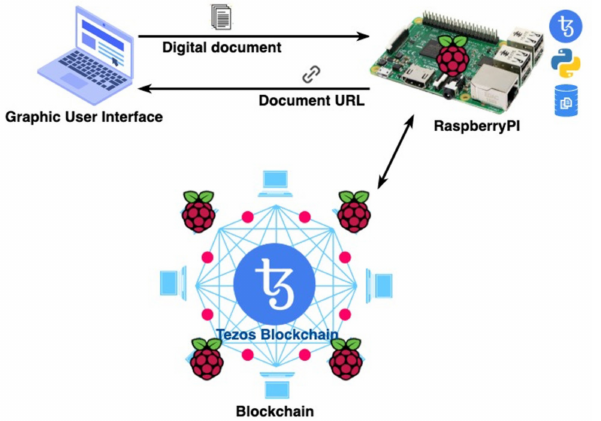
Figure 10. Nodes and groups of nodes can be hosted on different computing resources, from PCs to Raspberry